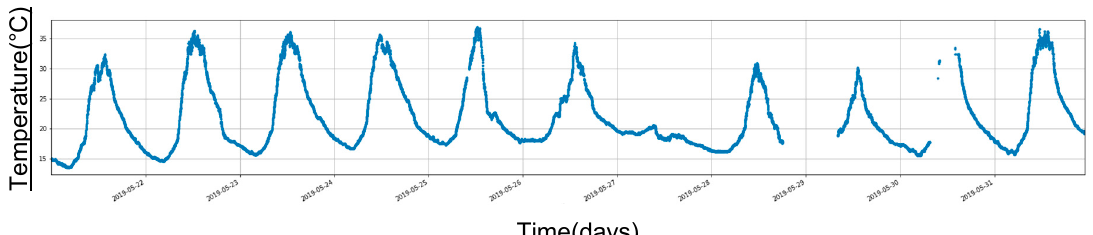
Electronics 2019 , 7 , x FOR PEER REVIEW Figure 8. Sample values of temperature-2 during May 2019 (before fitting). Figure 8. Sample values of temperature-2 during May 2019 (before fitting).